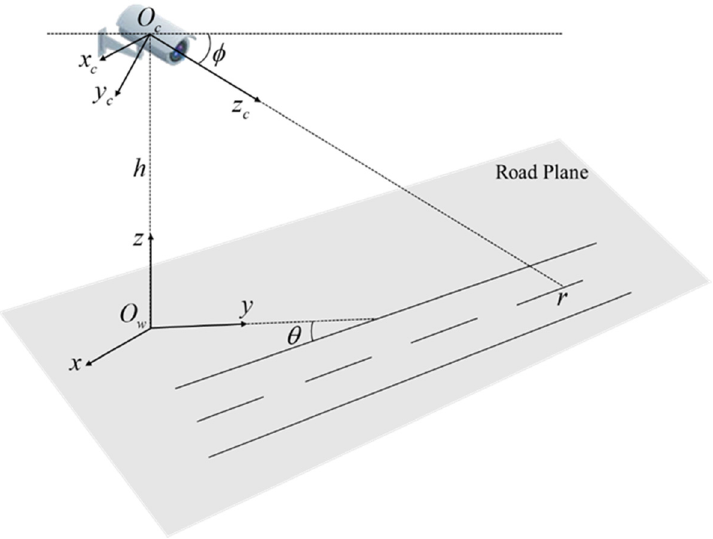
Figure 2. Schematic diagram of coordinate systems and camera calibration model.